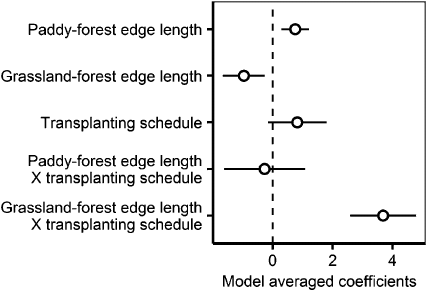
Figure 3. The estimated model averaged coefficients of the buzzards model that included interaction term. Error bars represent standard